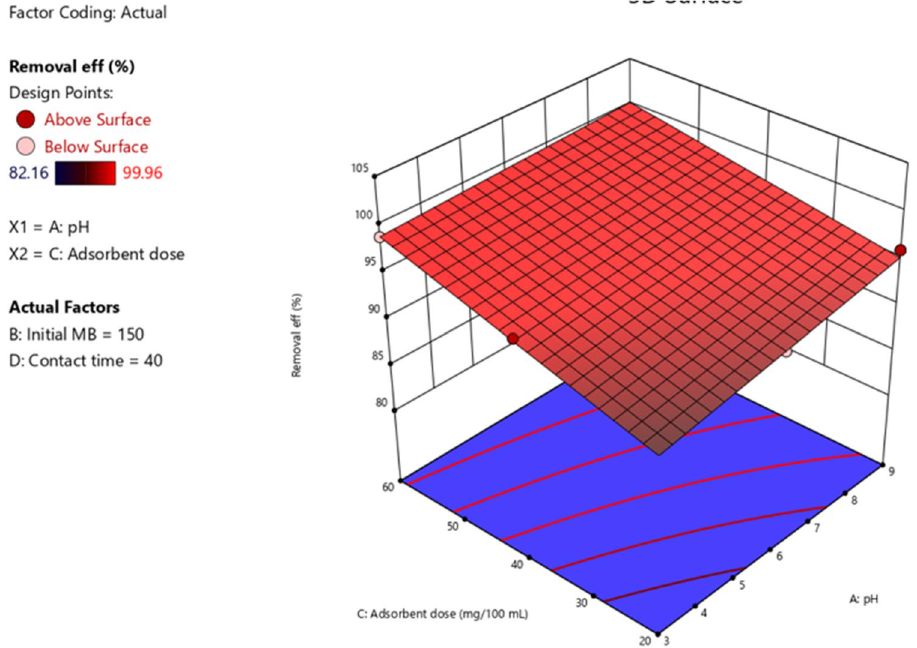
Figure 9. Interaction effect of adsorbent dosage and pH.